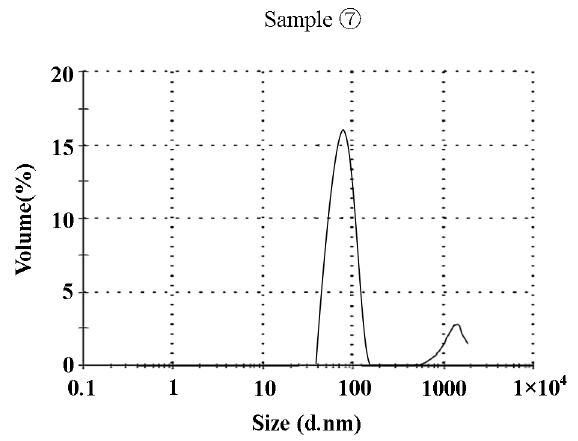
Figure 8. The particle size distribution of the system when the molar ratio of epoxy groups is E51:ED = 1:2.